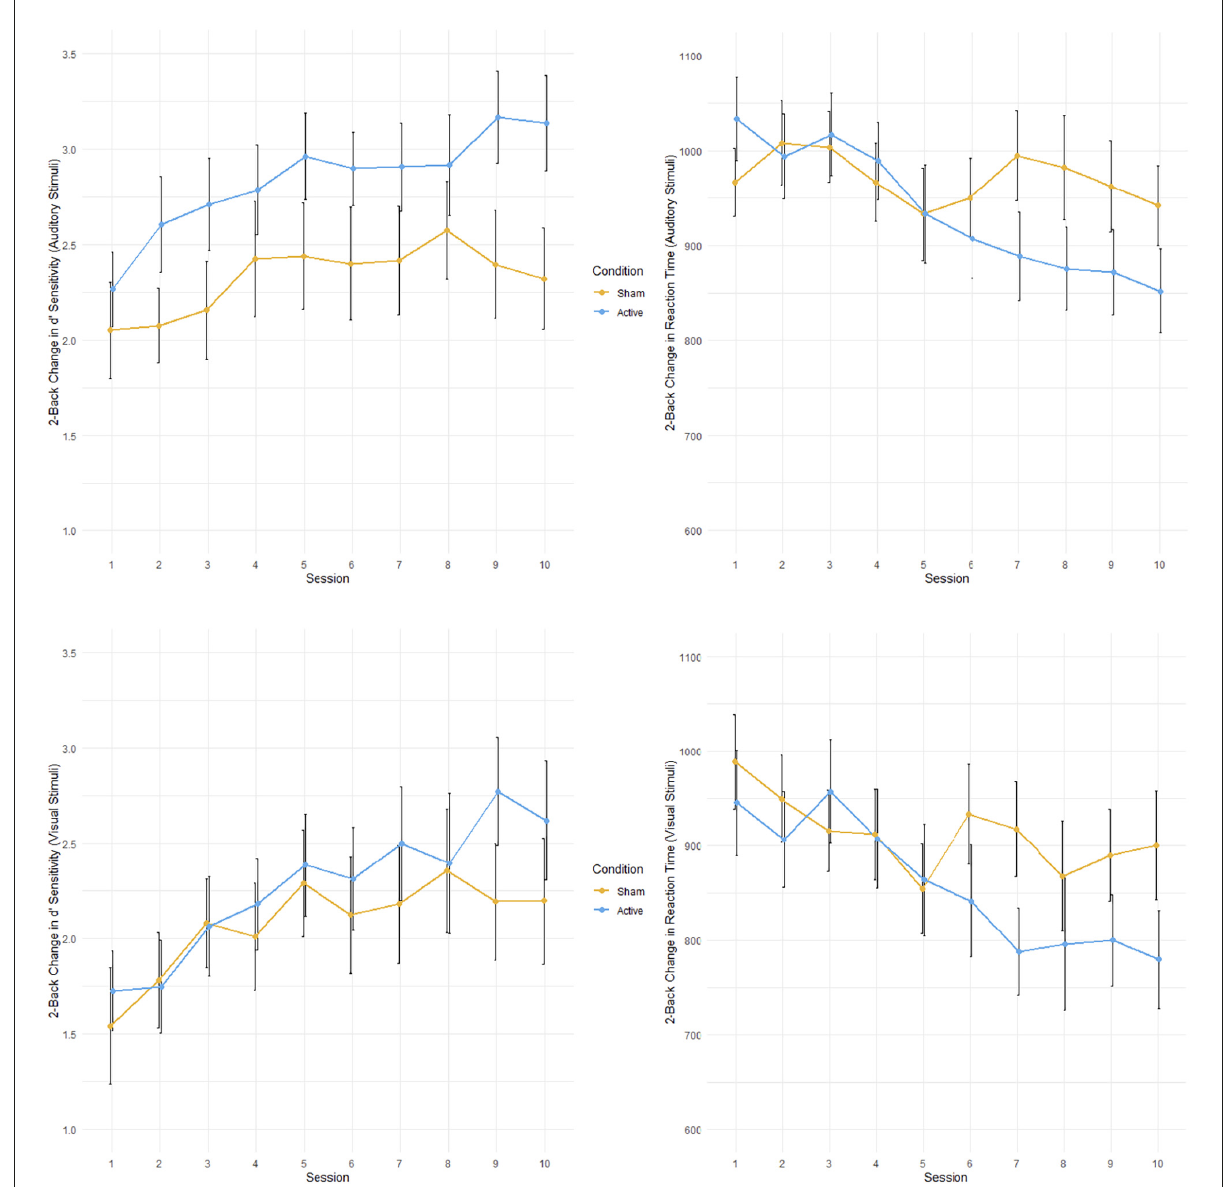
FIGURE3 Performance on multimodal working memory 2-back task during 10 tDCS sessions for active and control groups. Active in blue; control in orange. Top left : Accuracy (sensitivity; d’) for auditory stimuli. Top right : Reaction time (ms) for auditory stimuli. Bottom left : Accuracy for visual stimuli. Bottom right : Reaction time for visual stimuli. Error bars represent standard